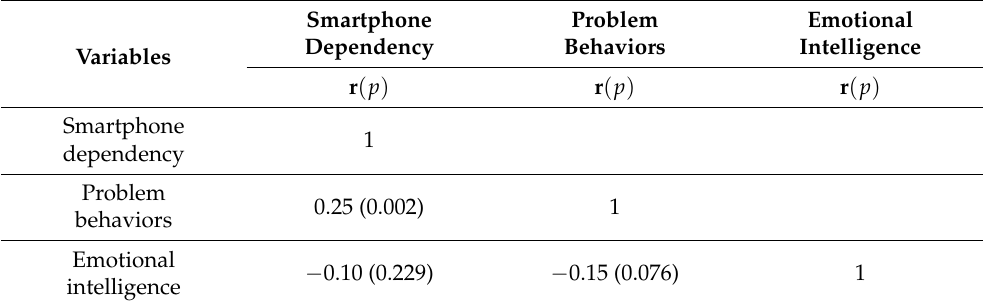
Table 4. Correlation between mothers’ smartphone dependency and children’s problem behavior and emotional intelligence. ( n =